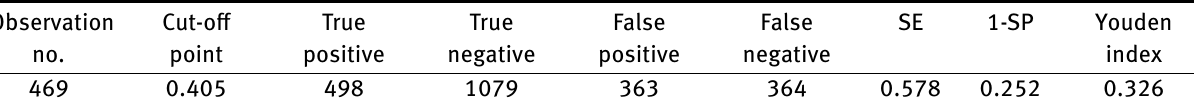
Table 5: Cut-off point of the logistic regression model studied.